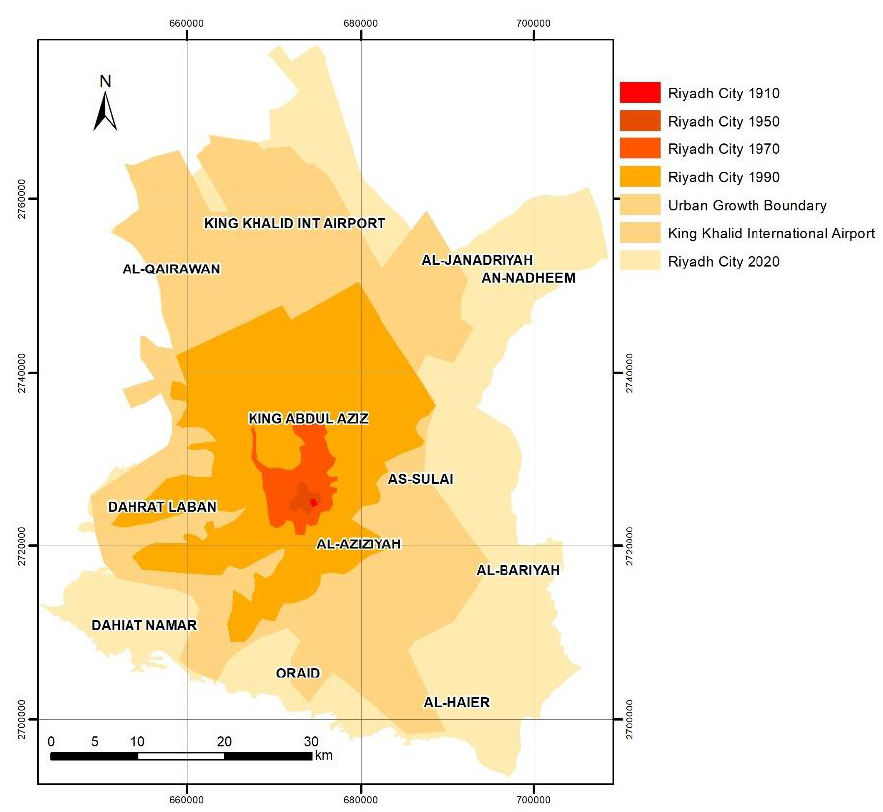
Figure 2. Al-Riyadh City and the urban growth boundaries (1910, 1950, 1970, and 1990) [52].